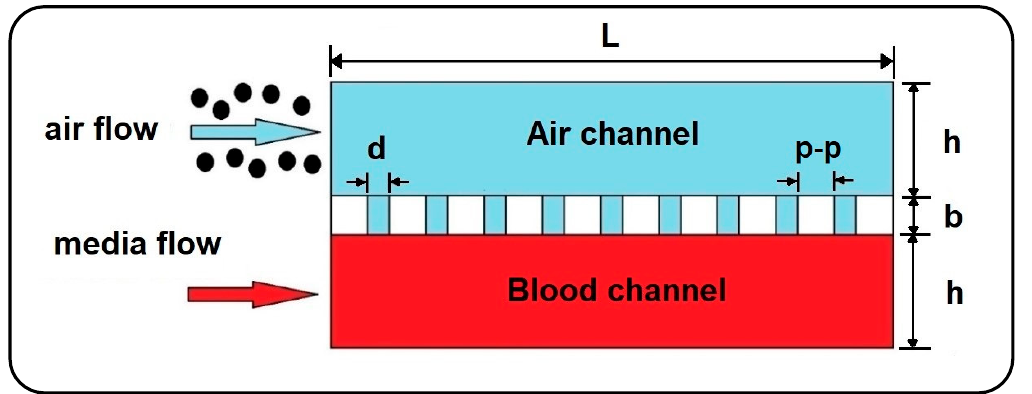
Figure 2. 2D model of airborne delivery of NPs into a gas-liquid dual-channel microdevice with a thin, porous membrane.